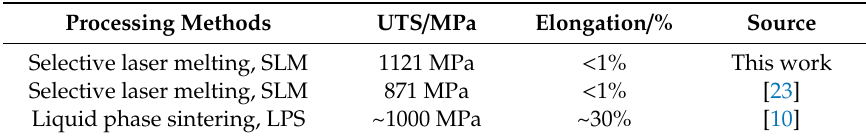
Figure 15. Tensile fracture morphology of 90W ‐ 7Ni ‐ 3Fe fabricated by SLM. ( a ) Low magnification; ( b ) high magnification of zone A ( a ). Table 4. Comparison of the tensile properties of 90W ‐ 7Ni ‐ 3Fe between this work and the published results.